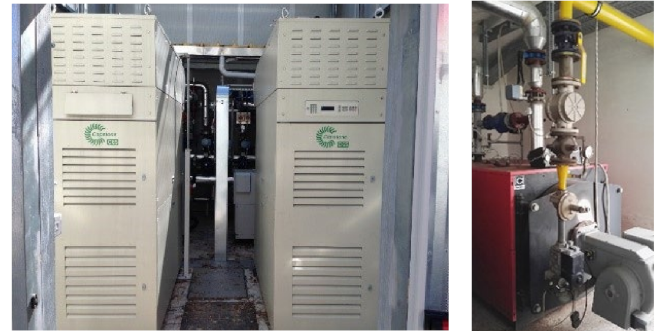
Figure 4. Microturbines ( left ) and one boiler ( right ) of the SPM [35].